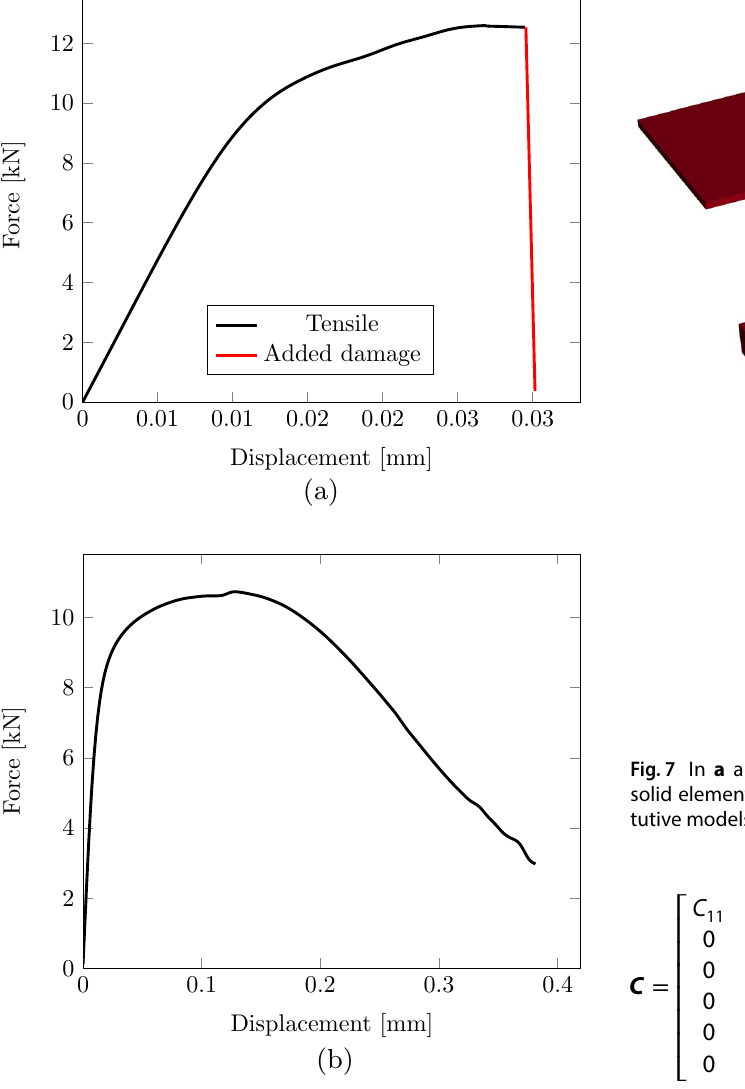
Fig. 6 Experimental force–displacement response curves for a tensile testing and b shear testing of the Hybrix™ micro-sandwich, obtained from the work by Hammarberg et al. [21]